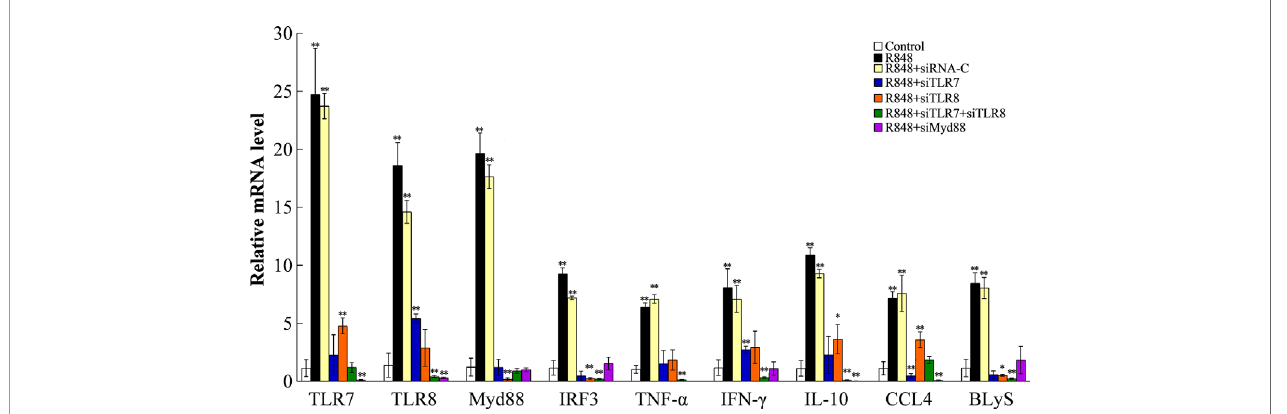
FIGURE 9 | Effect of R848 on the expression of immune genes through TLR7/8-Myd88-signaling pathway. Expression of golden pompano TLR7/8 and Myd88 were knocked down in golden pompano via siRNA technology. Then, fi sh were treated with or without (control) R848. The expression pro fi les of immune genes were investigated in head kidney by qRT-PCR. The internal reference gene was B2M . Values are shown as means ± SD (N=5), and the statistical signi fi cance is indicated. *P < 0.05, **P <